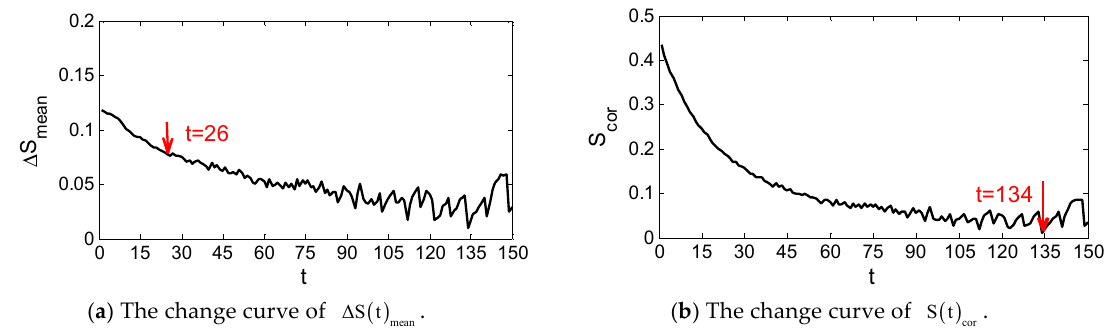
Figure 4. Results of ( )